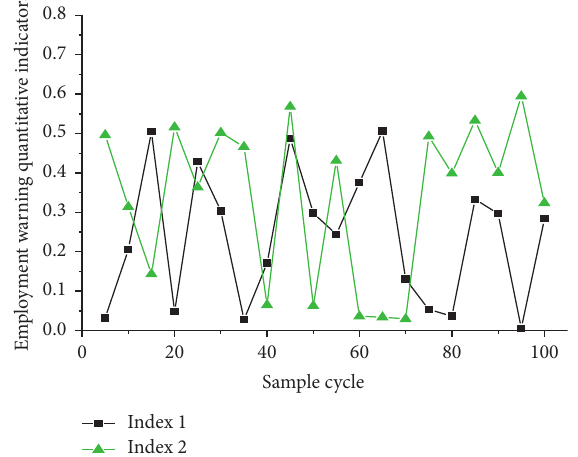
Figure 8: Comparison of quantitative indicators of employment early